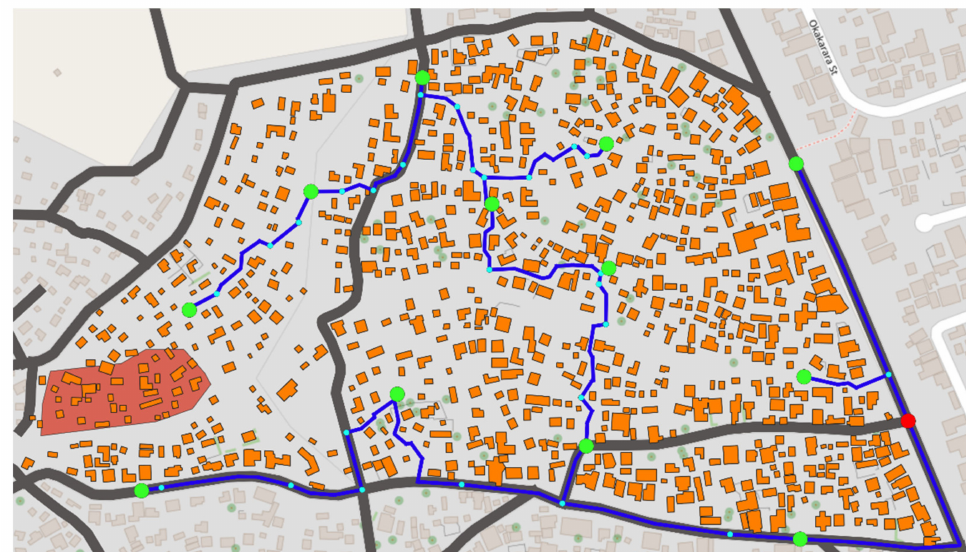
Figure 8. Result of the generated WDS (pipes: blue, water: points green, feeding point: red) where a cost factor of f road = 0.5 was applied for routing along existing paths/roads (basemap and buildings/polygons: [36]).